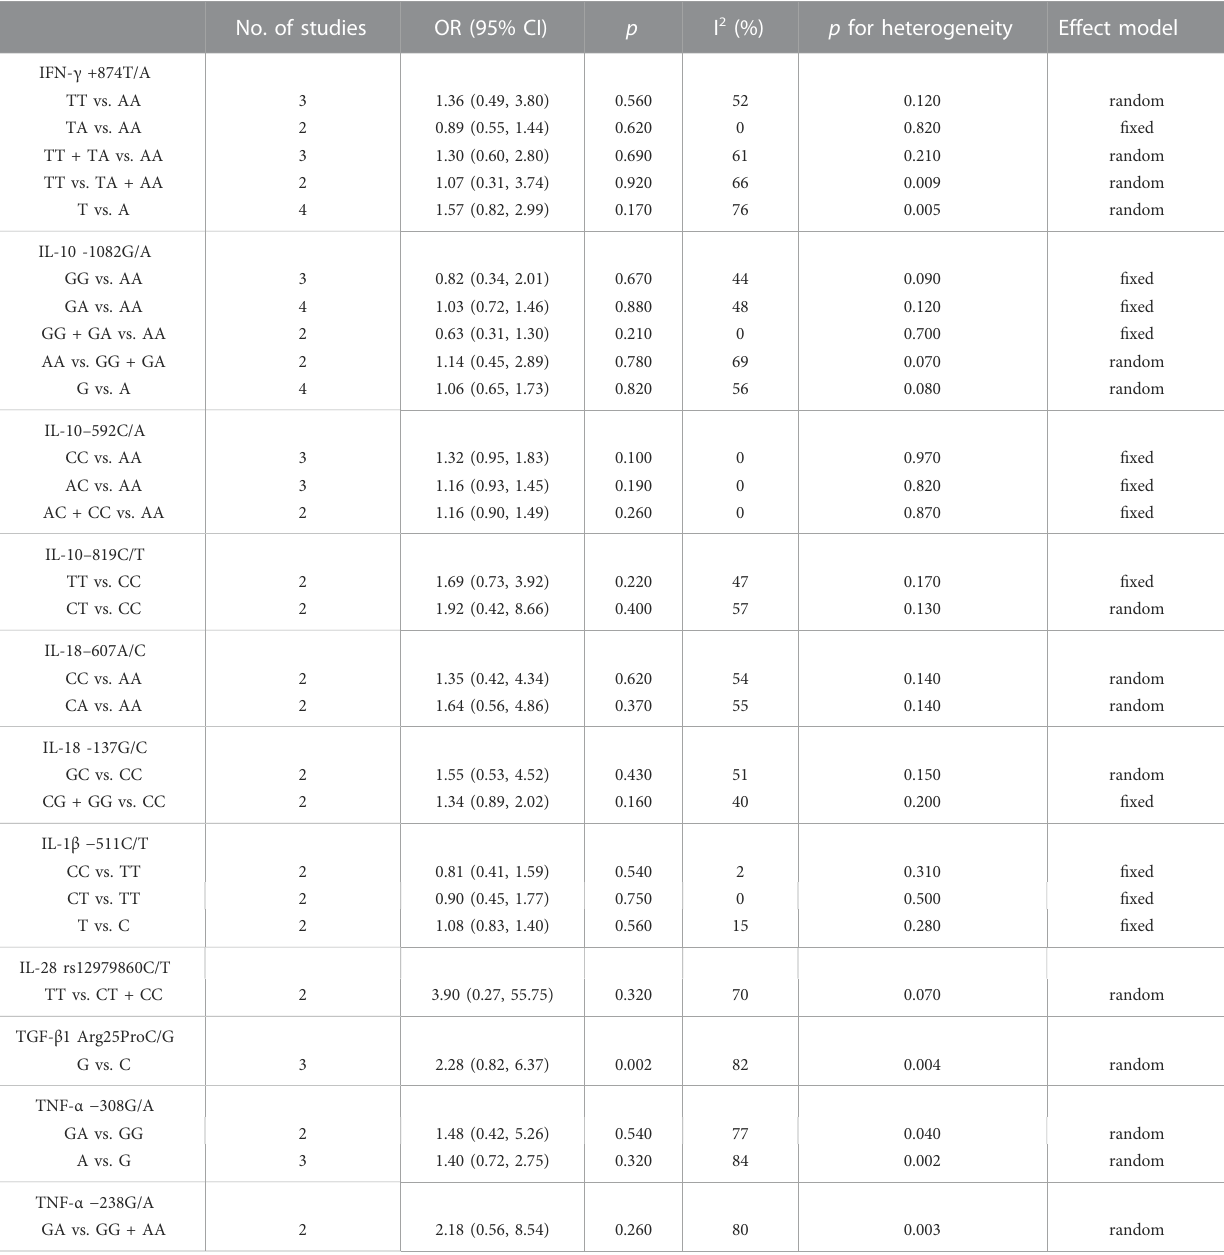
TABLE 2 Association between gene polymorphisms of in fl ammatory factors and liver